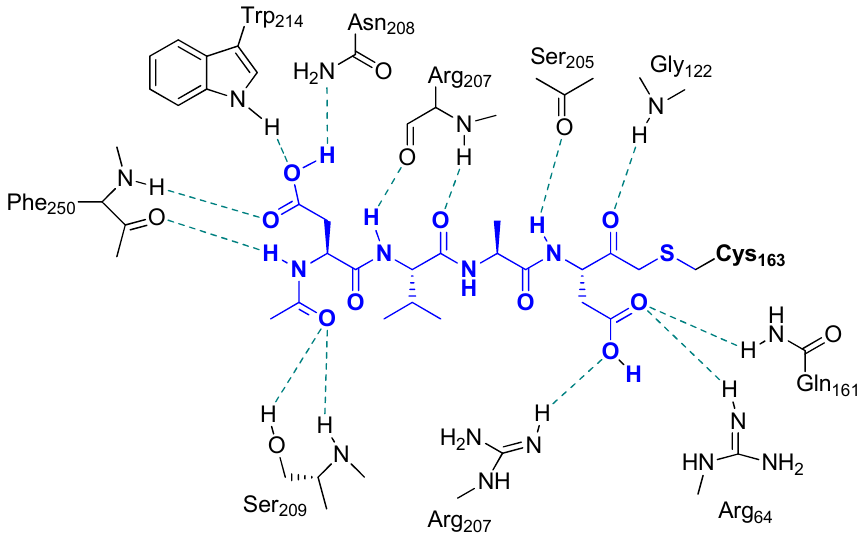
Figure 4. Main interactions observed for Ac-DVAD-FMK with Casp-3. The inhibitor was found covalently bound to the enzyme via formation of a thioether linkage with the side chain of Cys163.